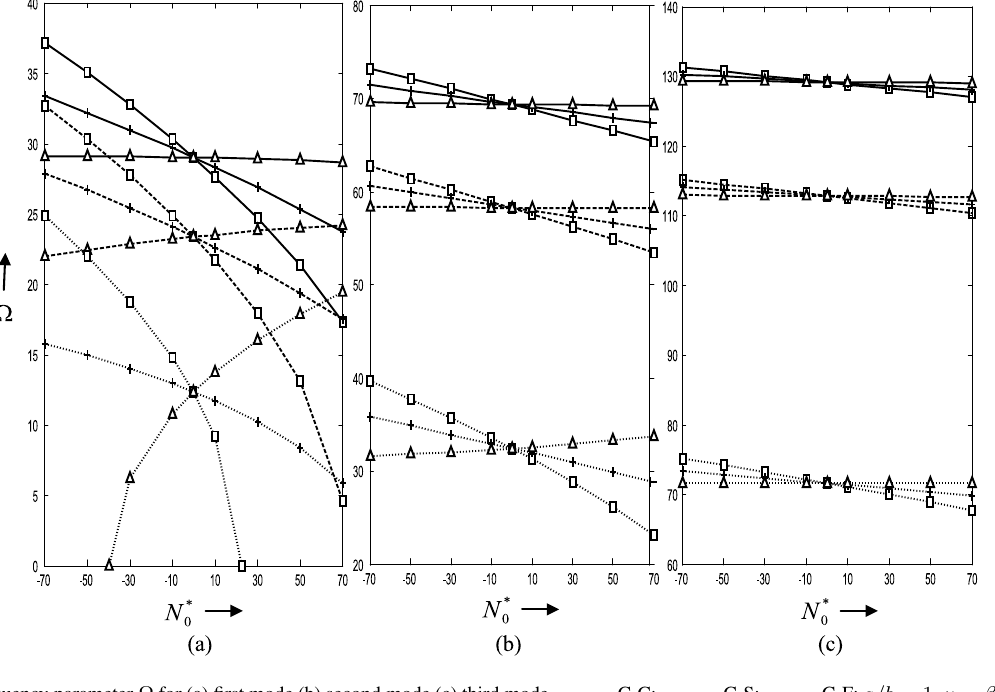
Fig. 4. Frequency parameter Ω for (a) first mode (b) second mode (c) third mode. _____, C-C; - - - - -, C-S; ......, C-F; a/b = 1 , μ = β = 0 . 5 ; (cid:3) , γ = 0 ; + , γ = 1 ; (cid:4) , γ = 2 .